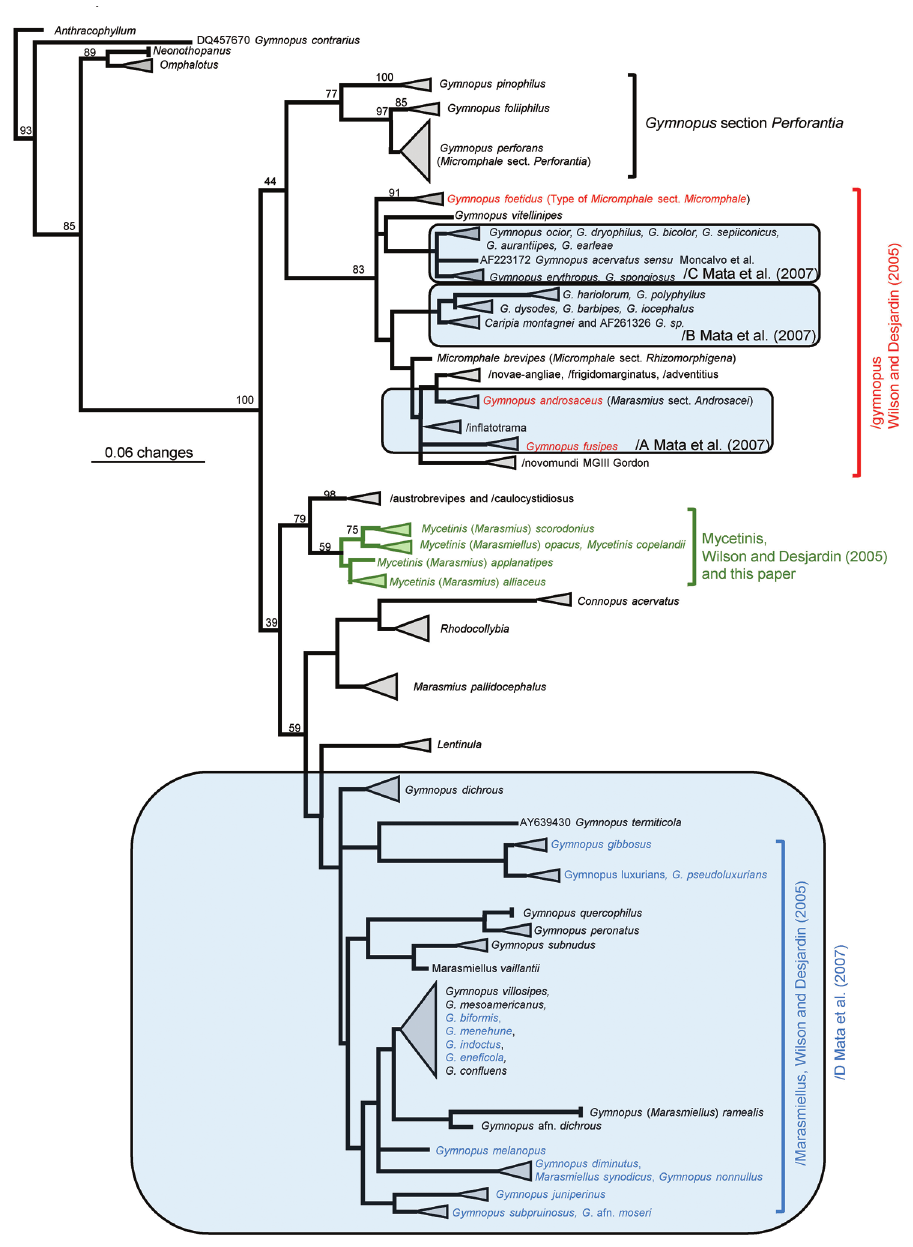
Figure 1. PhyML analysis of 191 nrLSU sequences within the Omphalotaceae using 100 bootstrap replicates (See also Petersen and Hughes, 2016). Clades were collapsed to better show broad relation- ships. Species names in blue represent /marasmiellus (Wilson and Desjardin, 2005). Species names in red represent /gymnopus (Wilson and Desjardin, 2005). The major clades reported in Mata et al. (2007) are overlaid in blue. Mycetinis is in